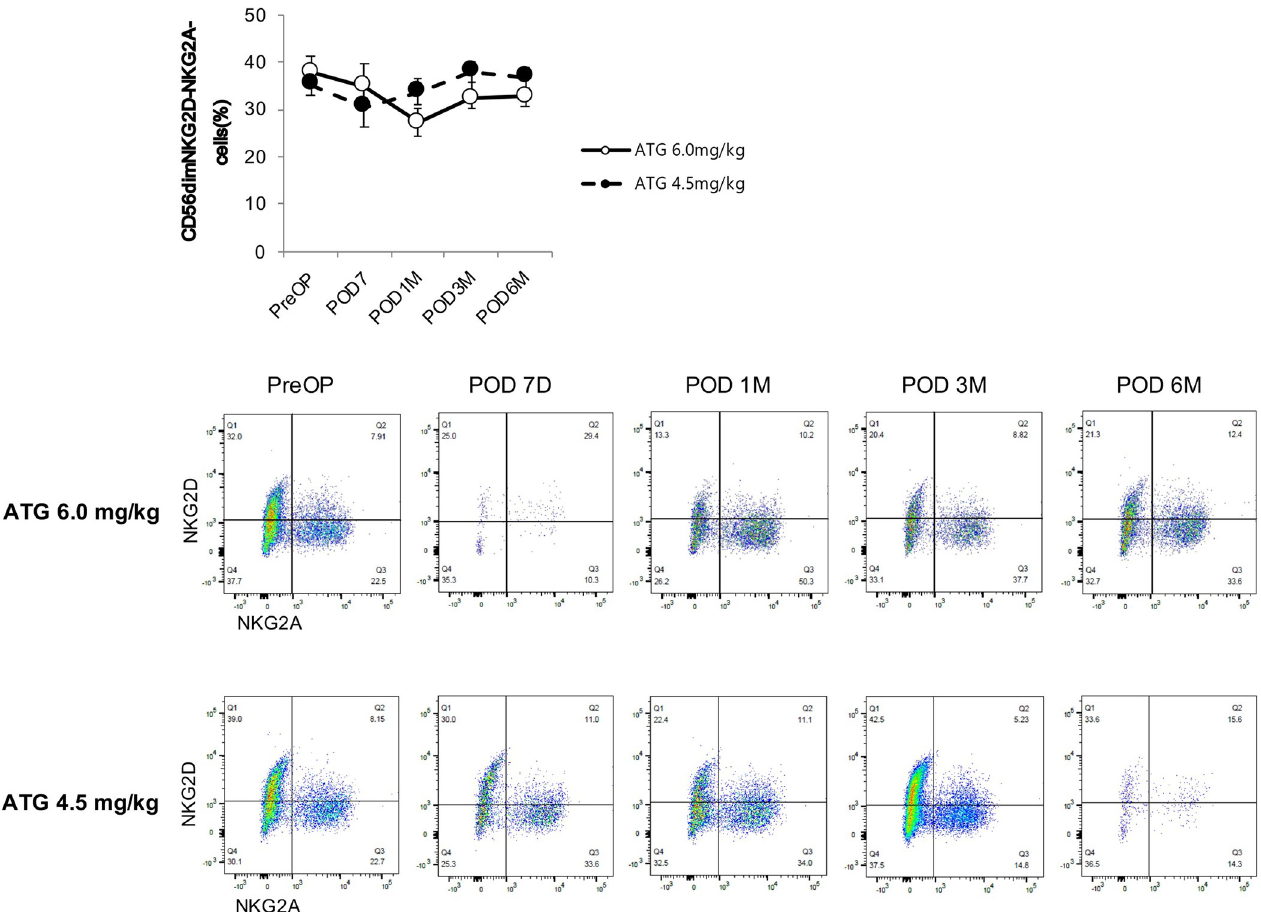
Fig 4. Proportion of NKG2D - NKG2A - cells among CD56 dim NK cells according to the dose of anti-thymocyte globulin. ATG, anti-thymocyte globulin.